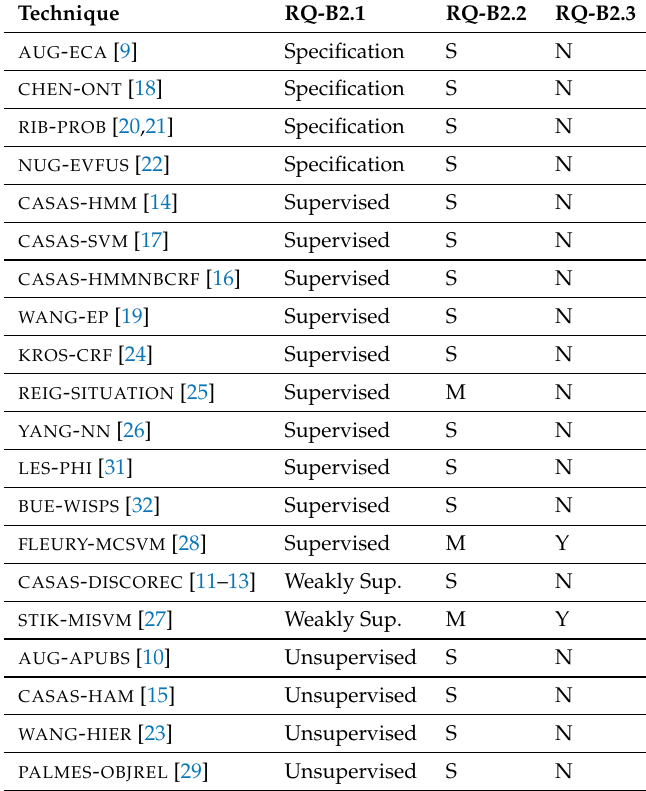
Table 4. Model construction (Y—Yes, N—No, S—Single, M—Multiple)—RQ-B2.1: Specification vs Learning (Supervised or Unsupervised)—RQ-B2.2: Number of users—RQ-B2.3: Labeling to address